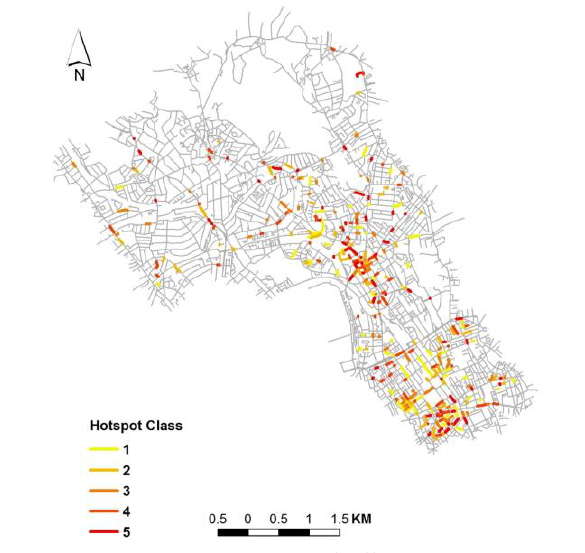
Figure 4. Hotspot map of different classes